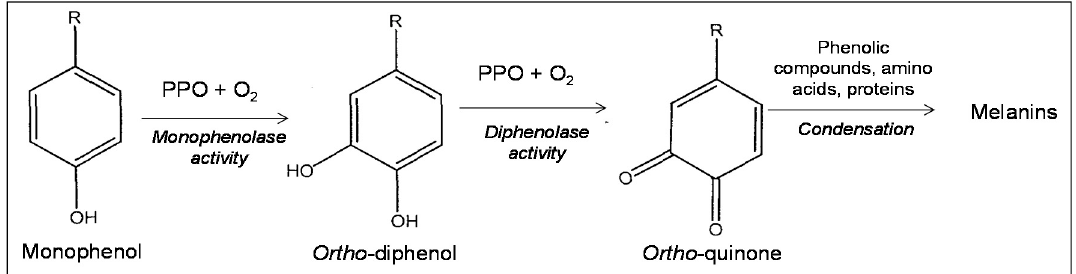
Figure 1. Simplified schematization of browning process. PPO, polyphenol oxidases.